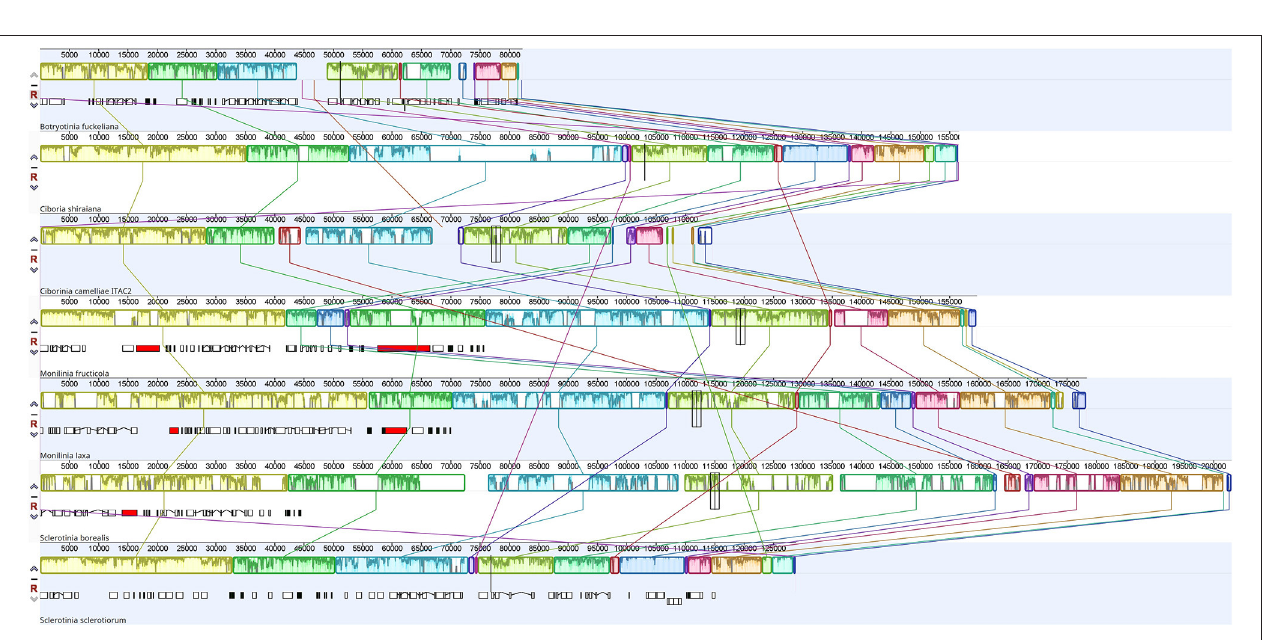
genome composed of a contig list was obtained from the whole genome assembly of C. camelliae ICMP 19812 strain from New Zealand ( Supplementary Data Sheet 5 ). Glarea lozoyensis was considered as an outgroup. The phylogenetic tree ( Figure 4 ), executed according to the model VT + F + R3, demonstrated a close connection between C. camelliae ITAC2 strain and the members of the Sclerotiniaceae family. The two C. camelliae strains group as an independent clade, distinct from the other Sclerotiniaceae species. They exhibit 95.4 and 98.3% of similarity in nucleotide and amino acid sequence,